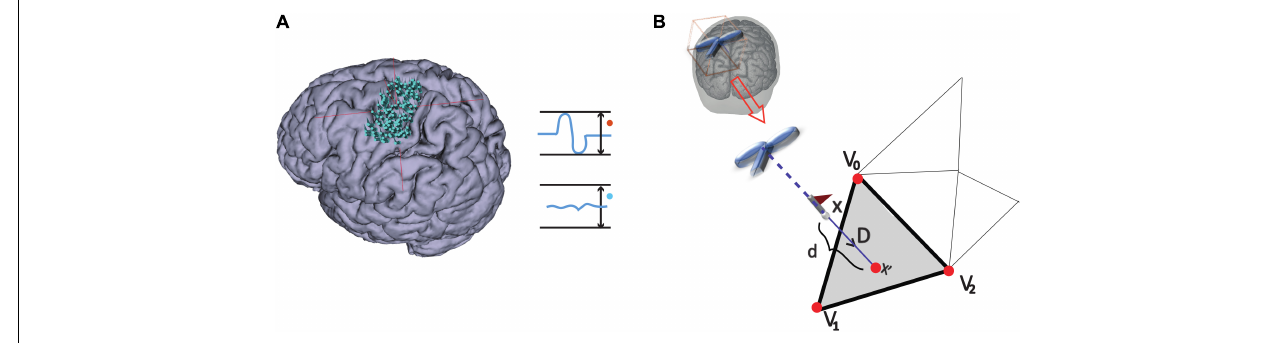
FIGURE 2 | MEP definition and point projection along the direction of coil orientation. (A) Stimulation points over the cortex that either elicited an MEP or not: MEP and non-MEP points, respectively. (B) The cortical surface nearest to a given stimulation location along the TMS coil orientation is represented by the gray triangle (step ii). The three vertices in the triangle are shown by the red points, while the flagged spots indicate the stimulation